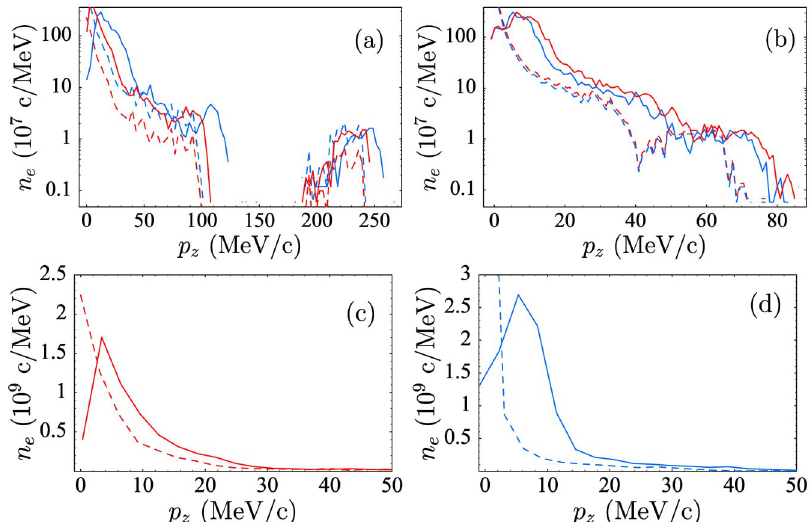
FIG. 16. (Color) (a) Logarithmic plot of the initial beam energy distribution (dashed line) and final (solid line) assuming a total beam charge of Q (cid:1) 2 : 8 nC (red) and Q (cid:1) 8 : 5 nC (blue) for the parameters of Fig. 15. (b) Same except for a higher density plasma without a preformed channel, assuming a total beam charge of Q (cid:1) 5 : 1 nC (blue) and Q (cid:1) 6 nC (red). A zoom of the low energy region, highlighting the changes in beam temperature induced by space-charge interaction, is shown in (c) for the channeled case [i.e., same as (a)] and in (d) for the single laser pulse experiment [corresponding to the log plot (b)]. The laser-plasma parameters for the latter (cid:1) 0 : 8 (cid:4) m , (cid:12) (cid:1) L=c (cid:1) 55 fs , r (cid:1) 7 : 4 (cid:4) m , n (cid:1) 4 (cid:5) 10 19 cm (cid:6) 3 example were a (cid:1) 2 : 2 , (cid:1) 0 0 0